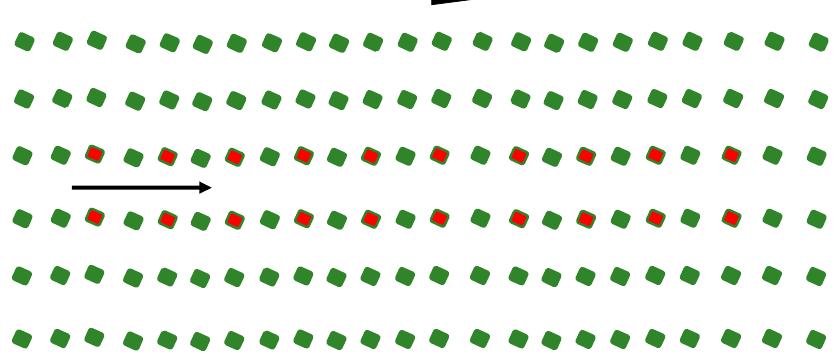
Figure 1. Position of the pairs of plants inside the examined vineyards.